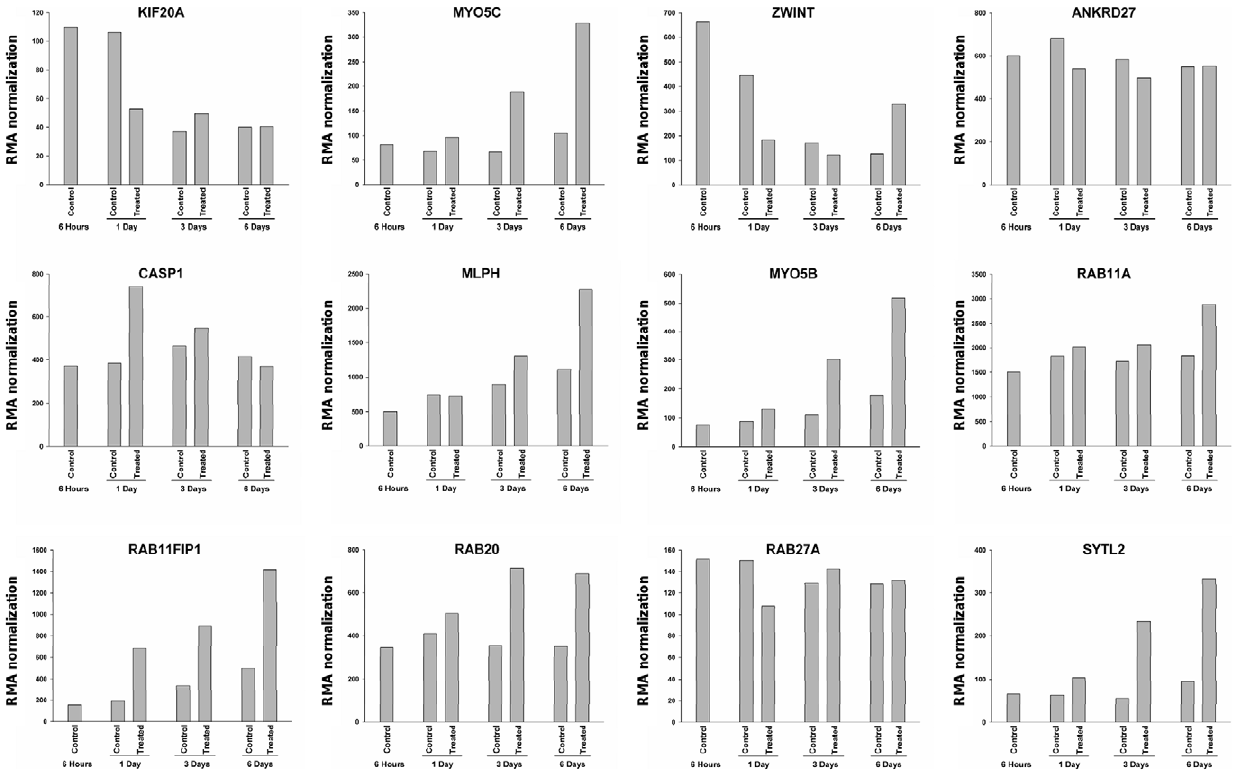
Figure 9. Gene expression in differentiated or non differentiated normal urothelial cells of the genes found to be associated with proliferation or differentiation in tumors. The expression of the genes found to be associated with proliferation or differentiation in tumors were measured in normal urothelial cells (NHU) in culture at four different times after passage: 6 hours, 1 day, 3 days and 6 days in differentiating conditions (in the presence of an inhibitor of EGFR and an activator of PPAR caamm in the NHU medium) or in non-differentiating conditions (NHU medium only).